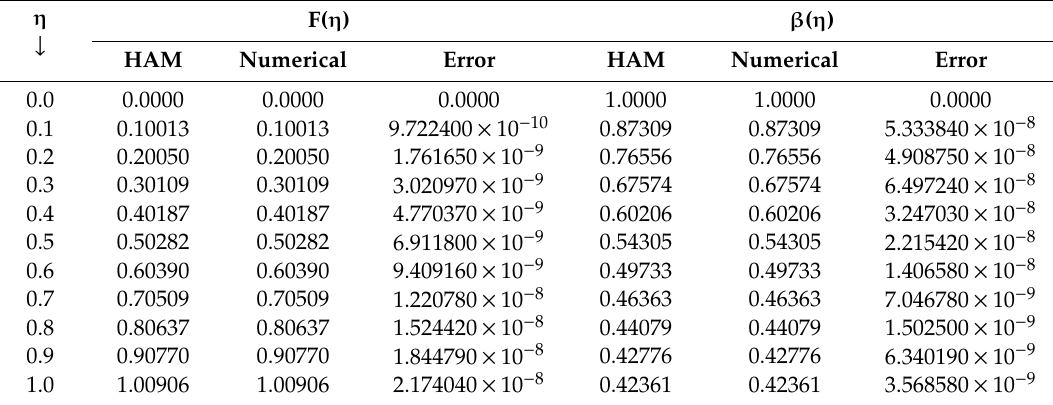
Table 5. Solutions of the